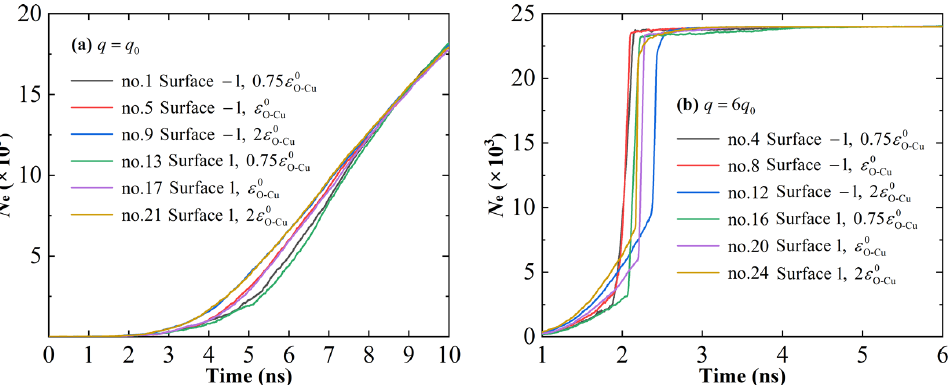
Figure 5. Comparison of the numbers of evaporated atoms of different nanorough surfaces at different wettability under a heat flux of ( a ) q 0 and ( b ) 6 q 0 .